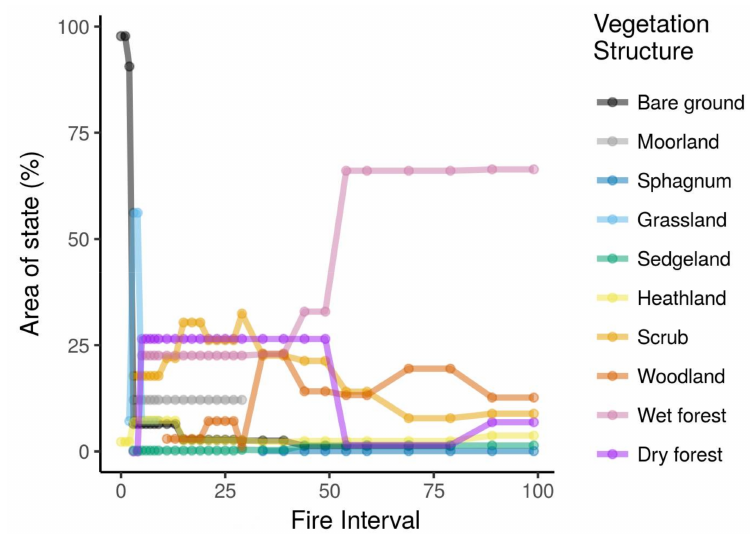
Figure 5. The change in the area of Tasmania covered by broad vegetation structural types after 100 years of burns at a range of fire intervals. The area at fire interval 0 corresponds to the distribution of vegetation types in the year 2000.